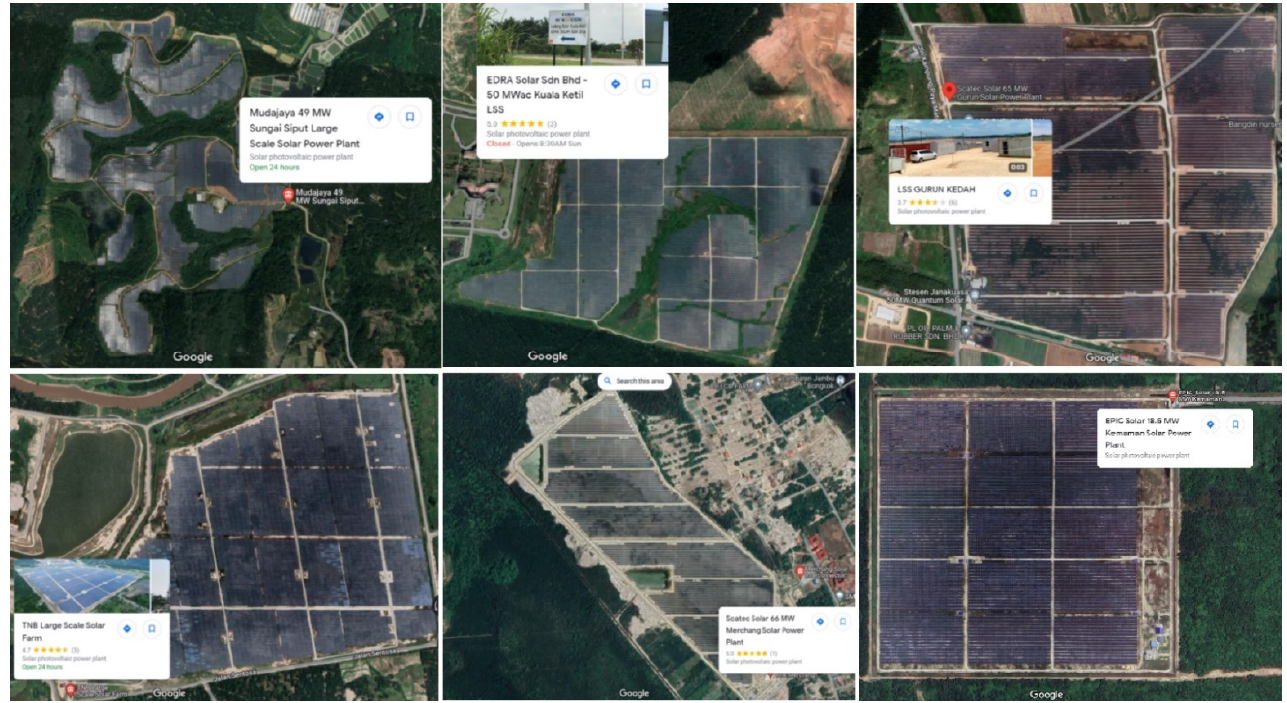
Figure 1. Typical LSS sites in Peninsular Malaysia [4].